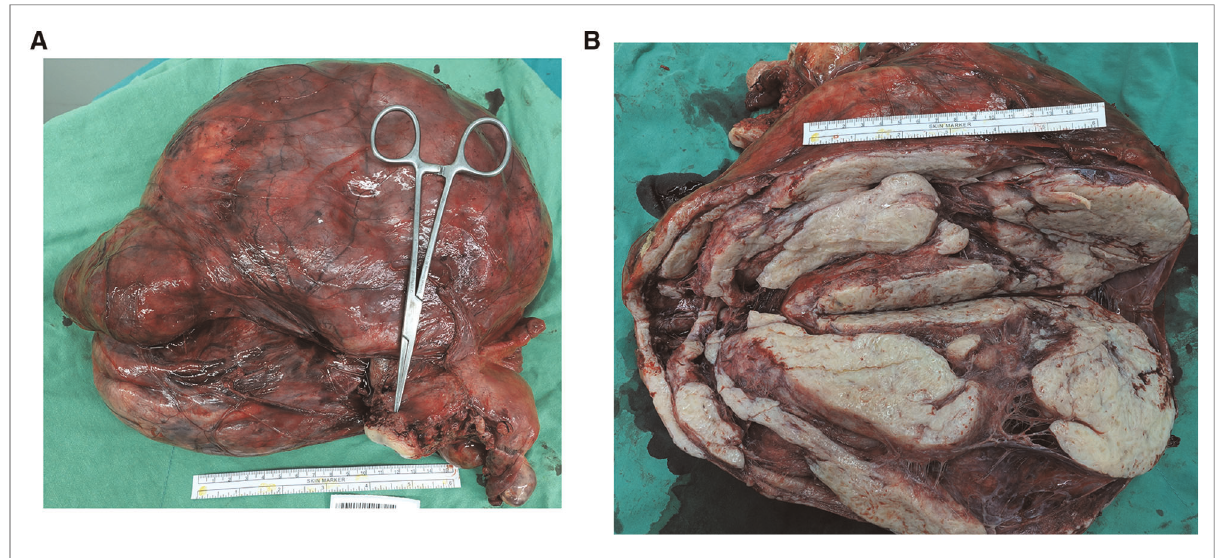
FIGURE 1 ( A,B ) The gross picture of the broad ligament myoma and incised specimen. The mass was found to have originated from the right broad ligament. The cervix was pointed by the tip of the Kelly clamp ( A ). The leiomyoma was throughout solid and presented with only a small portion of degeneration ( B